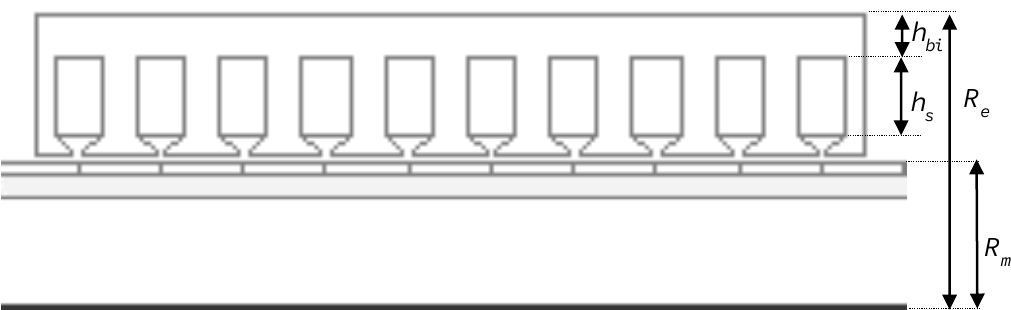
Figure 5. Split Ratio, 𝑅 𝑚 / 𝑅 𝑒 Refinement.